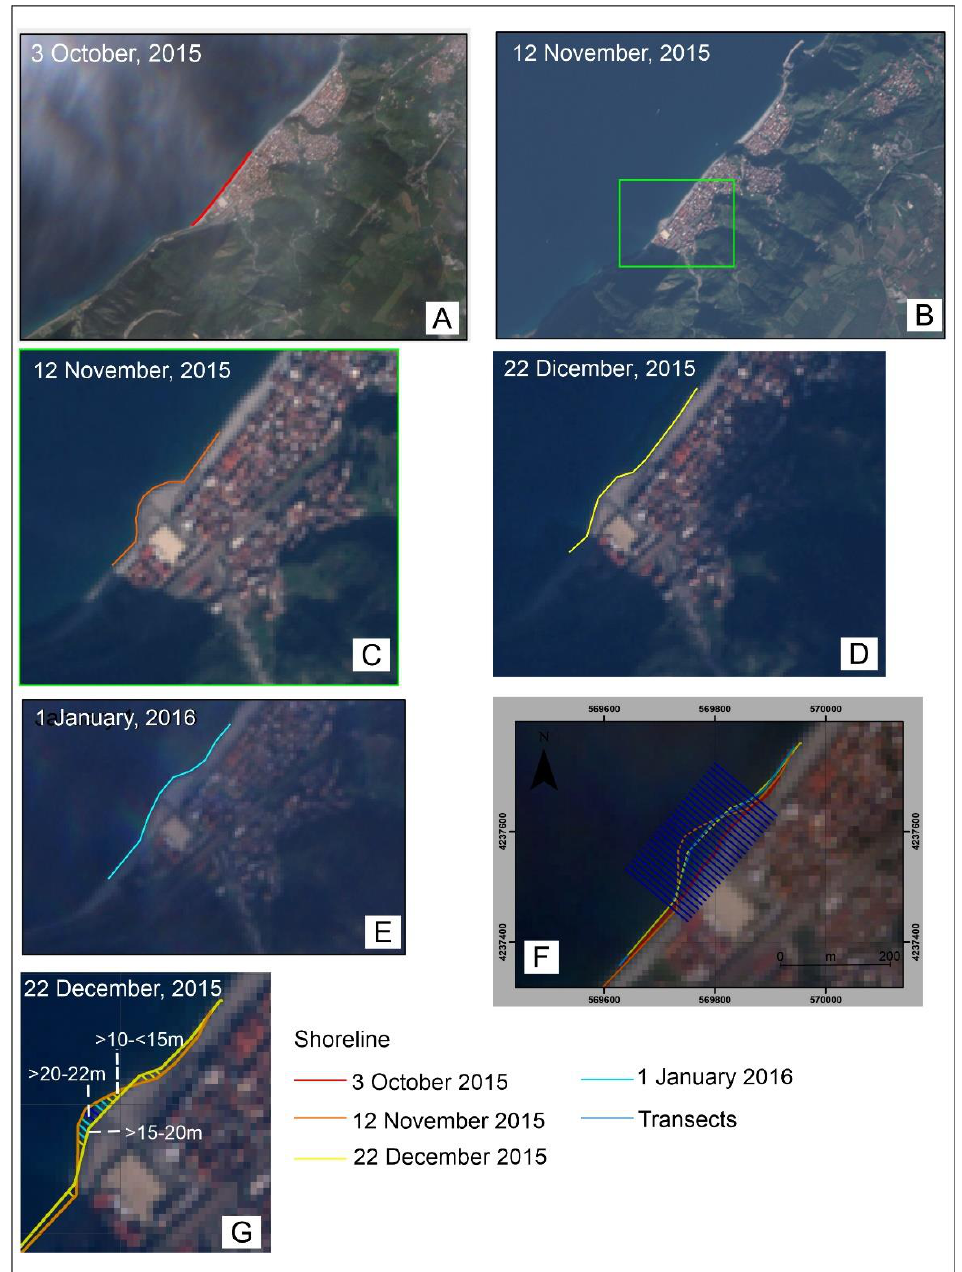
Figure 8. Sentinel 2 images show the development of the Sfalassà mouth: (i) before ( A ) and after ( B , C ) the flooding event of 2 October 2015; (ii) the fan-delta apex eroded by the storm surge occurred on 25-28 November 2015 ( D ); (iii) the unchanged fan delta morphology on 1 January 2016 ( E ). Image ( F ) shows the transects used to calculate shoreline variations. Image ( G ) displays shoreline change values between 12 November and 22 December 2015. Source: own elaboration overlaid to Sentinel 2 images.